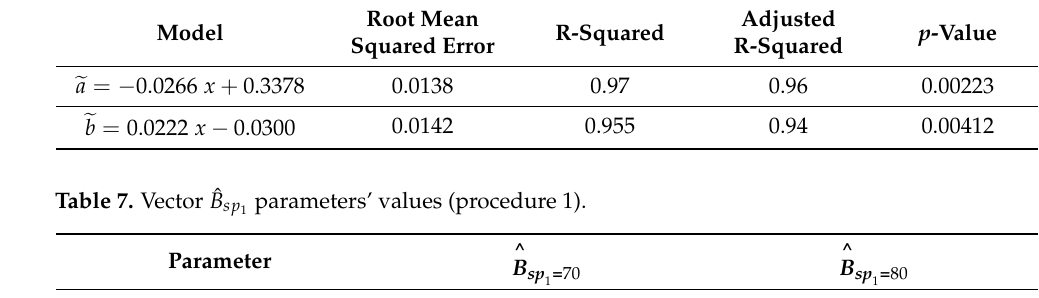
Table 6. Parameters’ models and statistics (procedure 1).